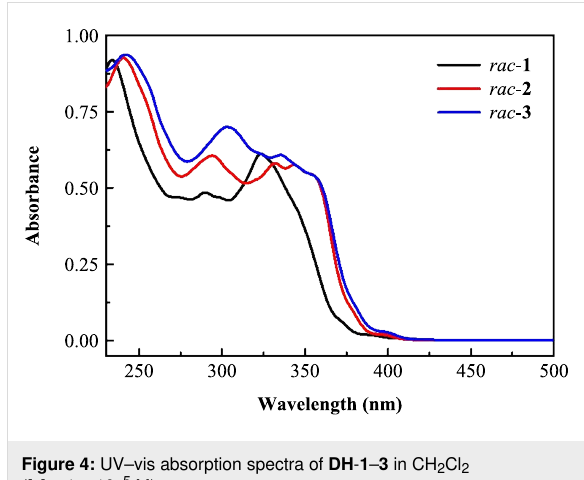
Figure 4: UV–vis absorption spectra of DH - 1 – 3 in CH 2 Cl 2 ([ c ] = 1 × 10 − 5 M).